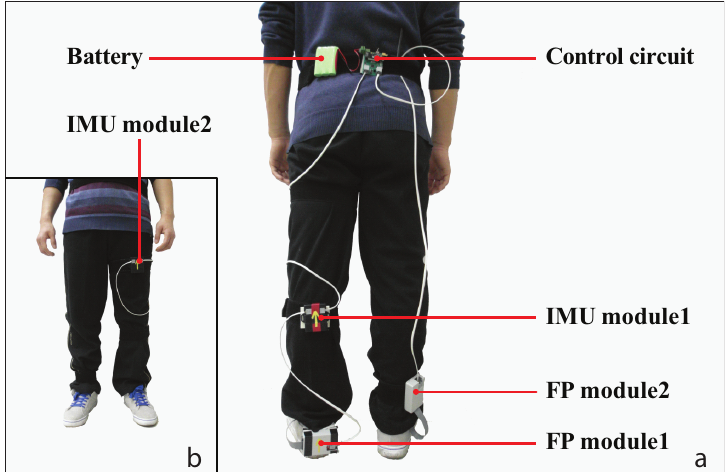
Figure 1. The placement of the sensors on human body. Foot pressure insoles are placed in shoes of both feet and the signals are sampled by circuits embedded in FP module1 and FP module2. IMUs used for recording the movement data of the thigh, the shank and the foot are embedded in IMU module1, IMU module2 and FP module1,